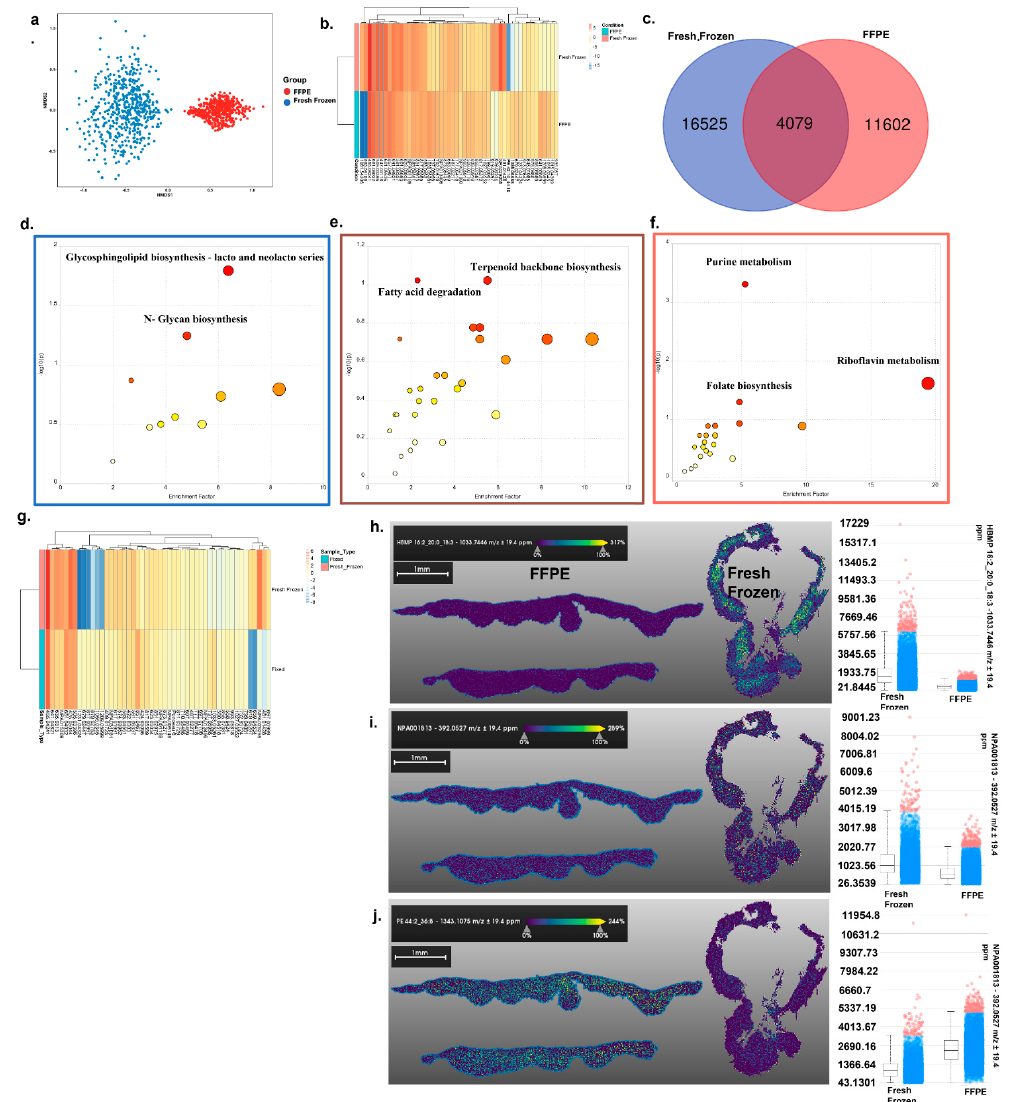
Figure 2. MALDI negative mode imaging of skin tissue: ( a ) Nonmetric dimensional plot of the metabolites present in fresh frozen and FFPE samples. Significant p -values from ANOSIM test showed there are differences in the metabolic profiles of the group tested (Stress: 0.03219174, ANOSIM statistic R: 1, significance: 1 × 10 − 4 ). ( b ) The heatmap plot of the top 50 most significantly different metabolites between the two groups. ( c ) Venn diagram showing the unique and shared putative metabolites between the two comparisons. ( d – f ) Metabolic pathway analysis plot created using MetaboAnalyst 5.0. Plots depict several metabolic pathway alterations when unique and shared metabolites from the fresh frozen and FFPE samples were tested. ( d ) Differential metabolites calculated from FFPE vs. fresh frozen. ( e ) Common metabolites from the Venn diagram were sorted based on p -value (high to low). ( f ) Differential metabolites calculated from fresh frozen vs. FFPE. (Pathway graph color box corresponds to the same color in Venn diagram). The y -axis is the –log10 of the p -value; pathways that were most significantly changed are characterized by high –log10( p ) values (top middle or right region). ( g ) The top 50 common metabolites were sorted based on p -value and represented as a heatmap. ( h – j ) Specific metabolite distribution images are presented along with an intensity box plot. ( h ) HBMP 16:2_20:0_18:3 distribution in both tissues and an intensity box plot of the same metabolite’s distribution. ( i ) NPA001813 distribution in both tissues and an intensity box plot of the same metabolite’s distribution. ( j ) PE 44:2_36:8 distribution in both tissues and an intensity box plot of the same metabolite’s